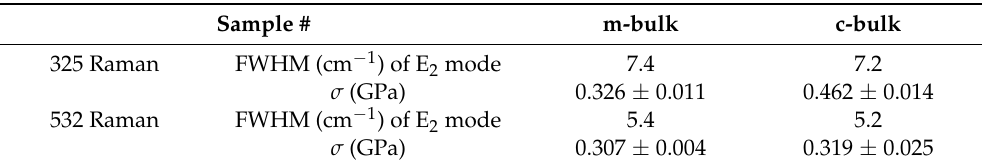
Figure 3. Room temperature Raman spectra excited by ( a ) 325 nm and ( b ) 532 nm laser for two bulk AlN crystals without a polarizer inserted in the optical path. Table 2. The full width at half maximum (FWHM) and biaxial stress of the E 2 (high) peak of two bulk AlN crystals at